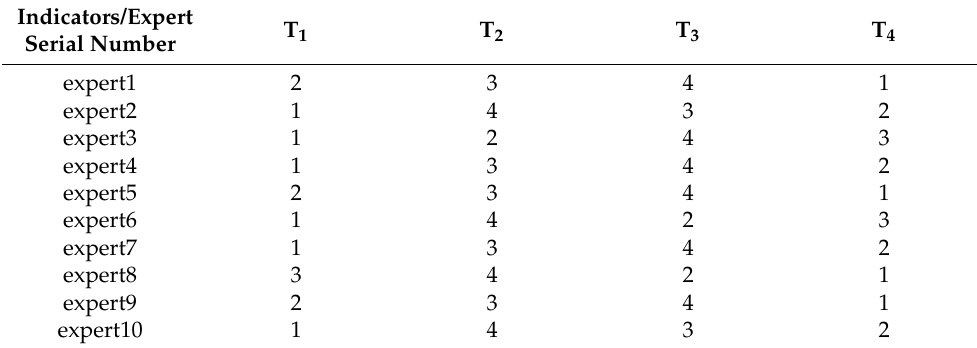
Table 9. The Importance ranking table of main indicator layer.